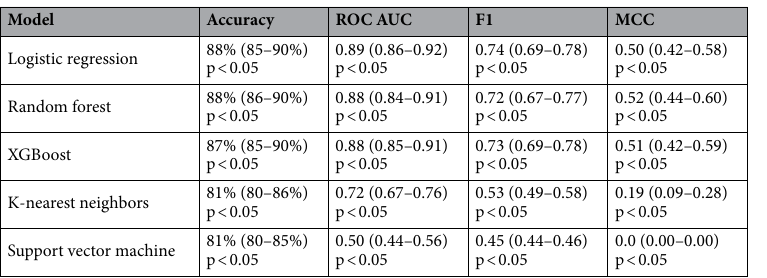
Table 4. Comparative chart displaying the accuracy score, area under the receiver operating characteristic curve, F1 score, and Matthews Correlation Coefficient (MCC) for each individual machine learning model. A 95% confidence interval is listed for each metric in parentheses, and a p-value expressing if a metric for each model is significantly different from the same metric from all the other models is